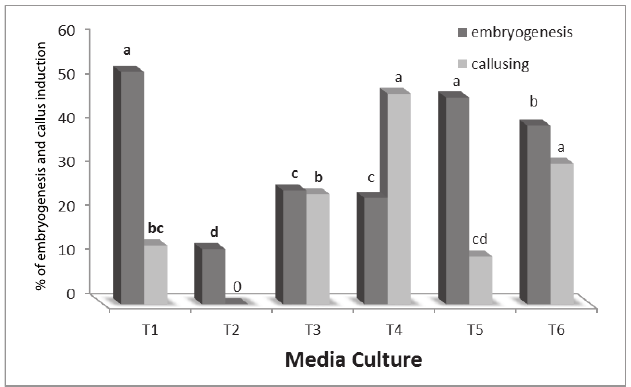
Fig. 1: Effects of different hormonal combinations on embryogenesis and callus induction in experiment 1. For every trait, letters compared separately. Means followed by a common letter are not significantly different at 5% level according to LSD test T1: 2,4-D+KIN (1.5+1 mg·l -1 ); T2: IBA+NAA+KIN+BAP (0.4+0.1+1+0.5 mg·l -1 ); T3: IAA+KIN+BAP (0.7+1.5+3 mg·l -1 ); T4: NAA+2,4-D+KIN+BAP (0.5+0.5+0.5+1.5 mg·l -1 ); T5: NAA+2,4-D+KIN+BAP (0.8+0.8+0.8+2.5 mg·l -1 ); T6: NAA+2,4-D+KIN+BAP (1.5+0.7+1+1.8 mg·l -1 )